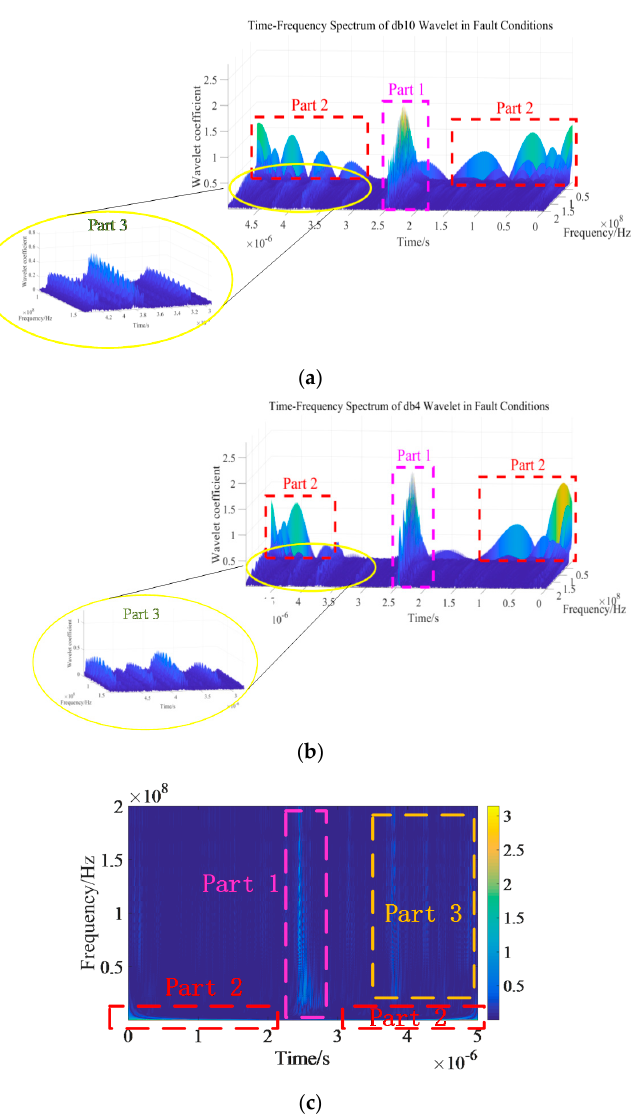
Figure 3. Time–frequency spectrum of the arc current based on the db10 and db4 wavelet: ( a ) time–frequency spectrum of the arc current based on db10; ( b ) time-frequency spectrum of the arc current based on db4; ( c ) two-dimensional spectrum of the arc current based on db4.